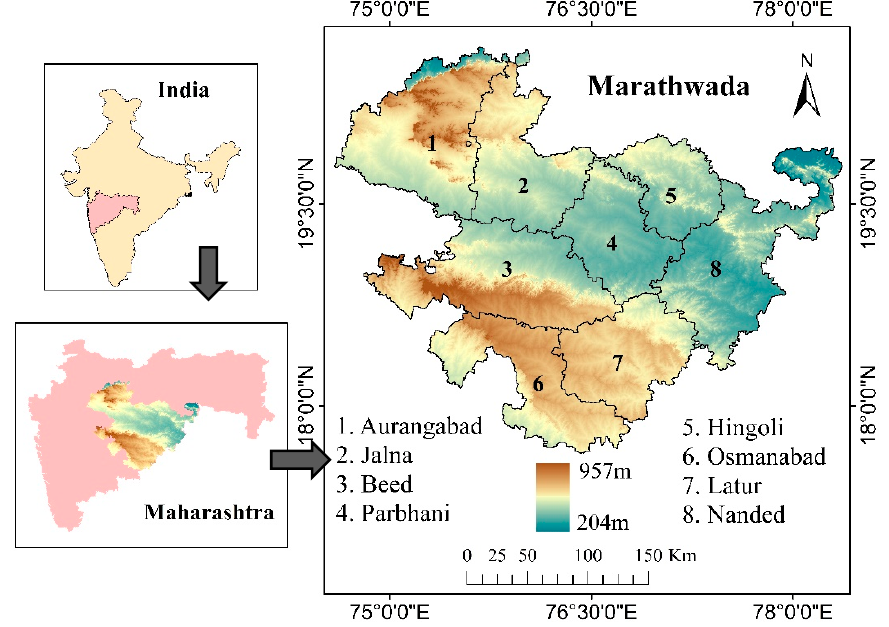
Figure 1. District wise extent, elevation variation, and location of the study area.